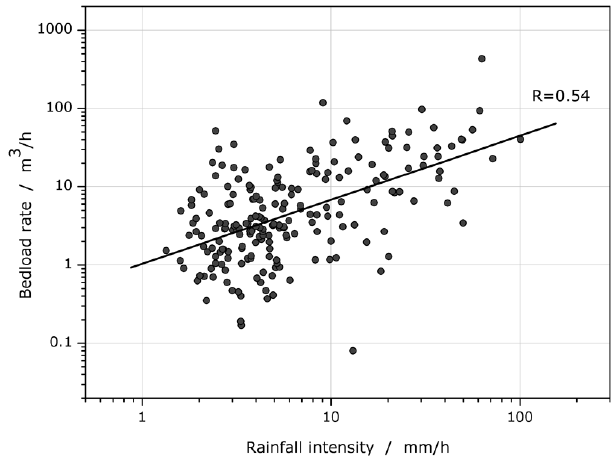
Fig. 9. Bedload rate plotted against mean rainfall intensity for all large bedload events recorded in the Erlenbach catchment (cf. Fig.